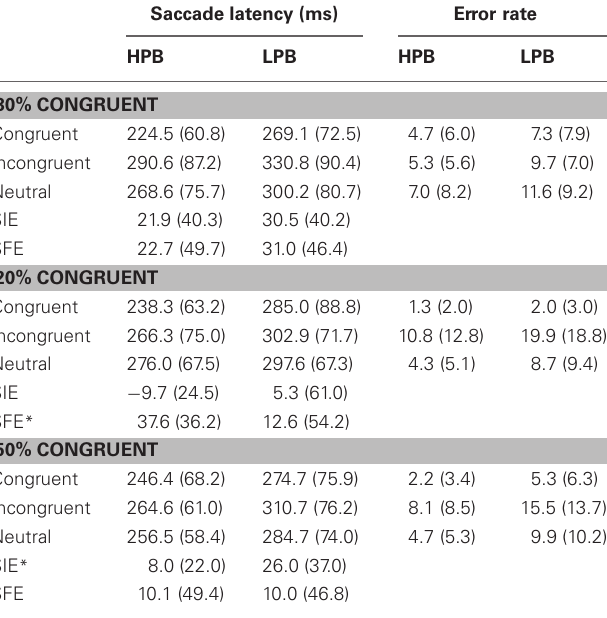
Table 3 | Mean saccadic latencies to the correct target, error rate, SIE (Stroop interference effect), and SFE (Stroop facilitation effect) for high and low proficient bilinguals (HPB and LPB) for the all the three monitoring